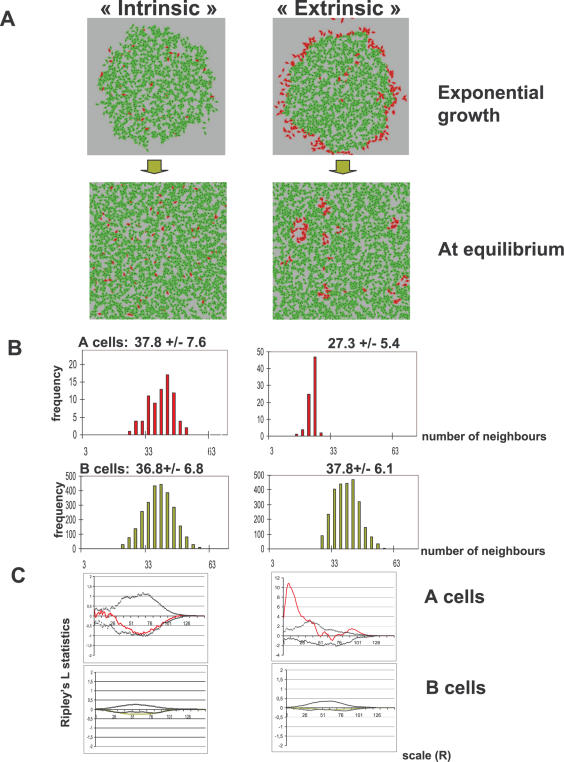
Results of a typical simulations.
A: Results of a typical run at the exponential growth phase and at equilibrium (type A cells are red and type B cells are green). Left panels: “intrinsic” phenotypic switch; right panels: “extrinsic” phenotypic switch.. In all simulations Nmax death = 40 was used. B: The distribution of the number of neighbours around the A and B cells (upper and lower panels, respectively) in the “extrinsic” (left) and “intrinsic” (right) models. The average number of neighbours and the standard deviation is indicated for each panel. C: Analysis of the spatial randomness of cell distribution at equilibrium using Ripley's L statistics. Ripley's L a point pattern with those generated by a homogeneous Poisson process. The plot shows the estimate of L(h) for various values of R ( = radius of a circle around the cell), and compares them to the line y = 0 (expected in a homogeneous Poisson process). An envelope defining the confidence interval is obtained from the maximum and minimum L(h) estimates of a large number of Monte Carlo simulations. The point set is significantly clustered in the range of scales where the estimated L(h) values are larger than 0 and lay outside the region defined by the envelope. This is the case for type A cells when considering small distances in the “extrinsic” model (red line). However, there is no significant clustering of type A cells (red line) in the “intrinsic” model and no clustering of type B cells (green line) in any of the two models, because all L(h) values are close to 0 and lay inside the region defined by the envelope (black lines).